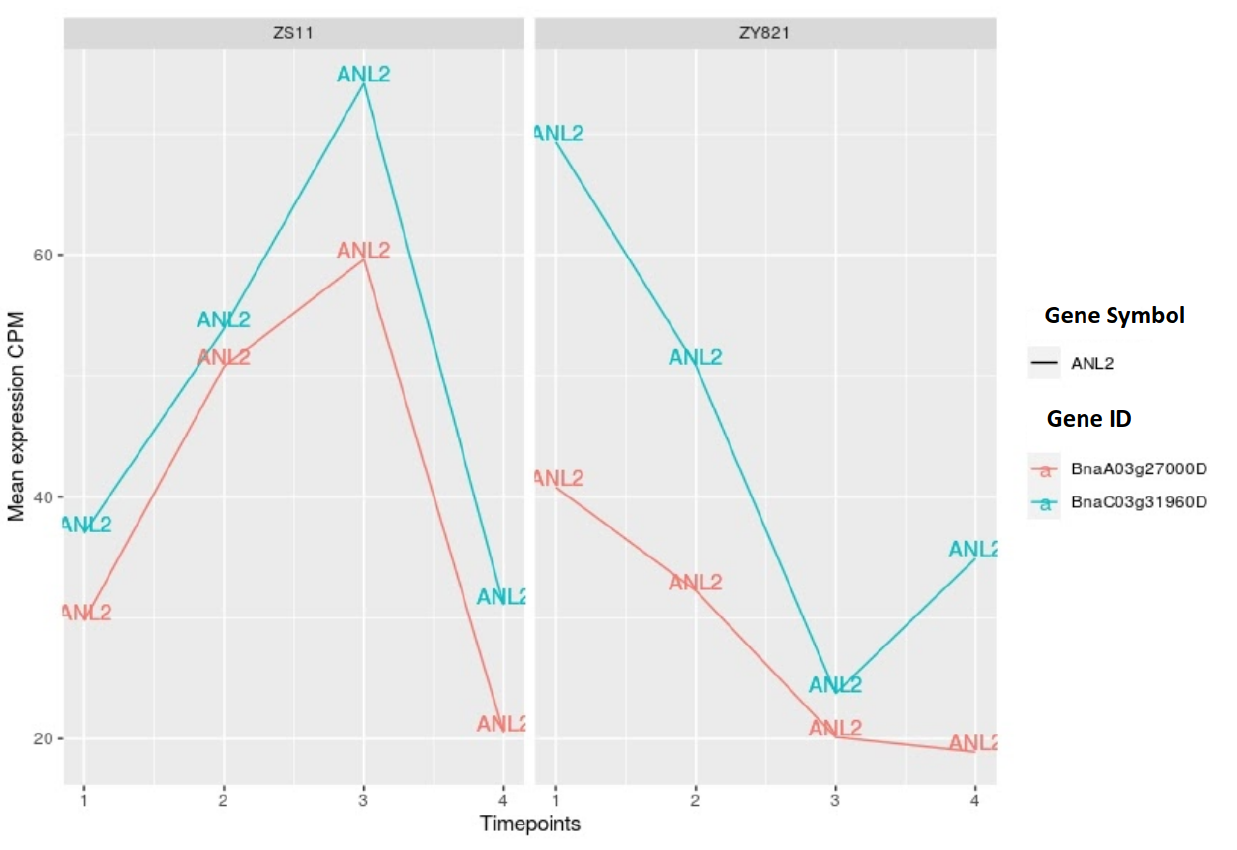
Figure 7. Expression values of ANL2 orthologous genes. Time points 1 to 4 represents day 7, day 10, day 15, and day 45 after